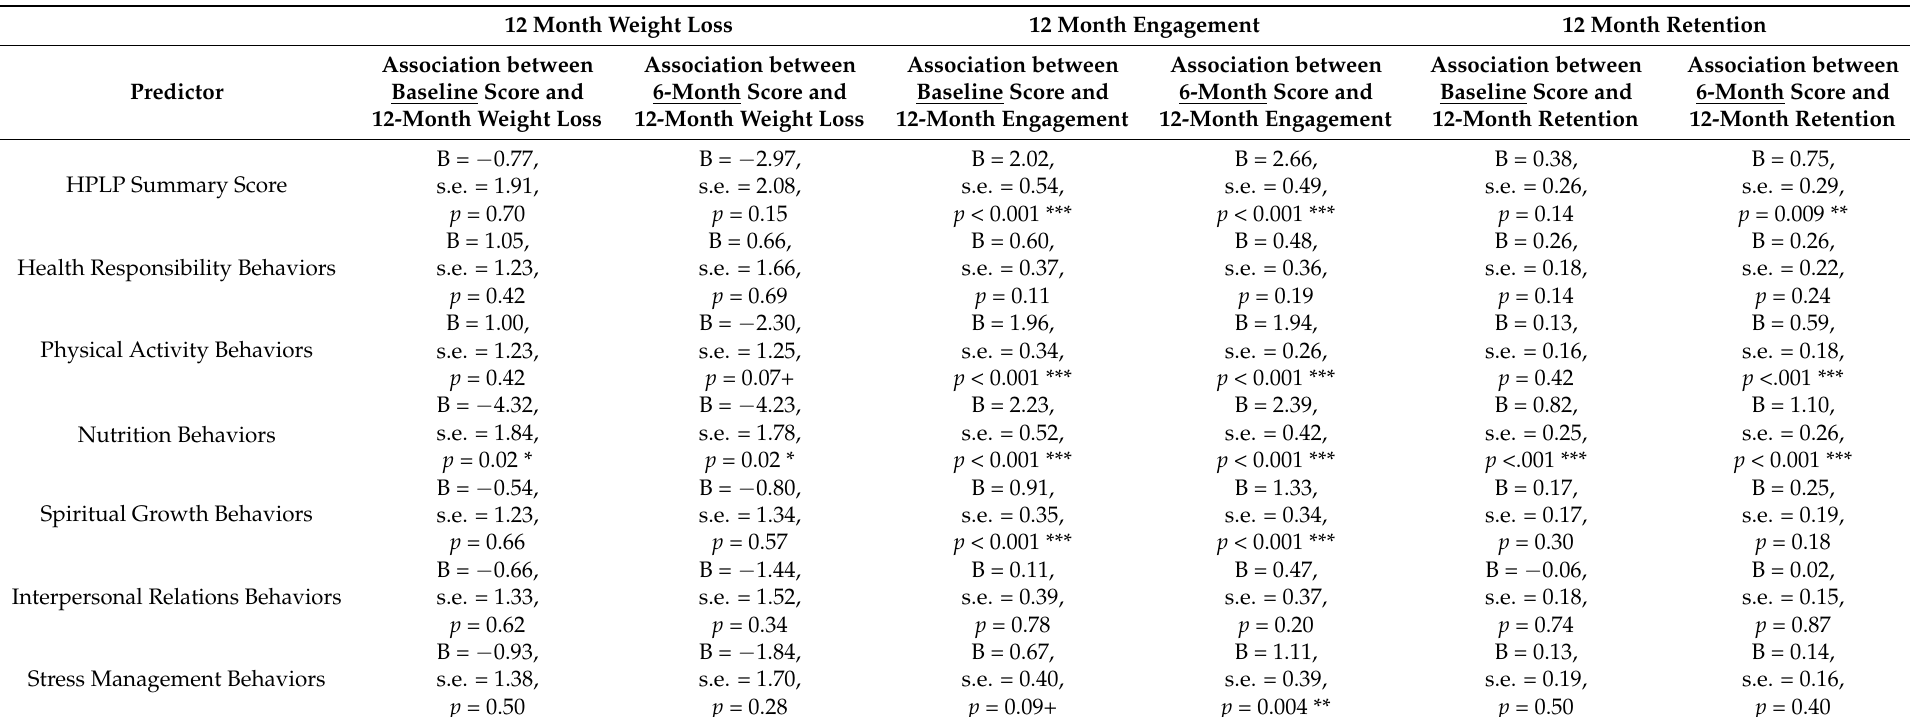
Table 2. HPLP-II Scores and 12 Month Weight Loss, Engagement, and